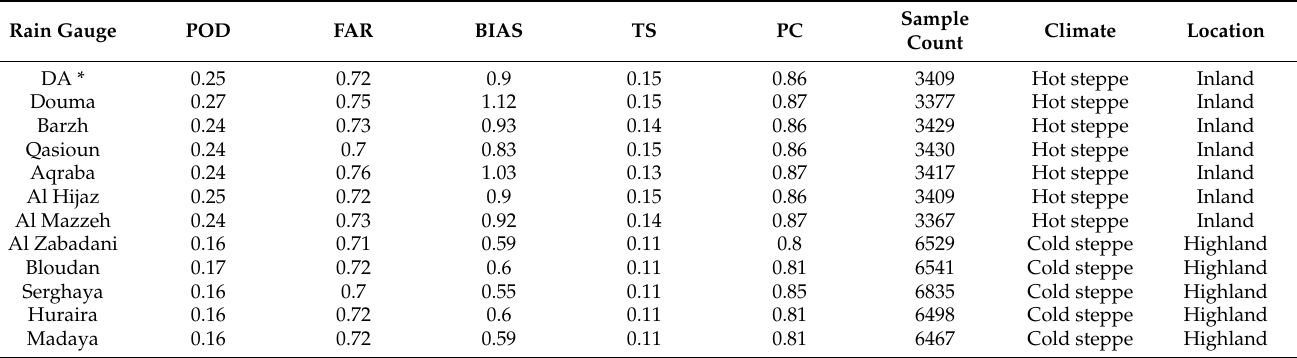
Table 4. The results of categorical statistics for all gauges in the Barada Basin.